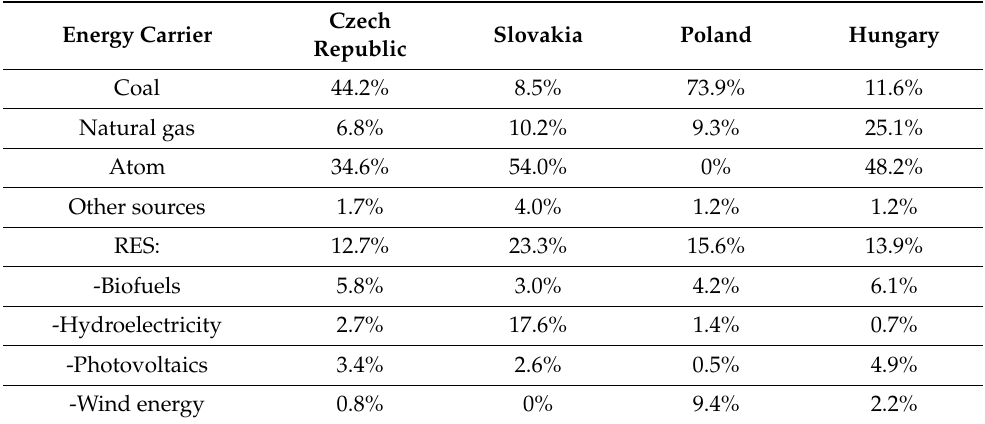
Table 1. Structure of net electricity generation in the Visegrad countries in 2019, Developed from [33]. Energy